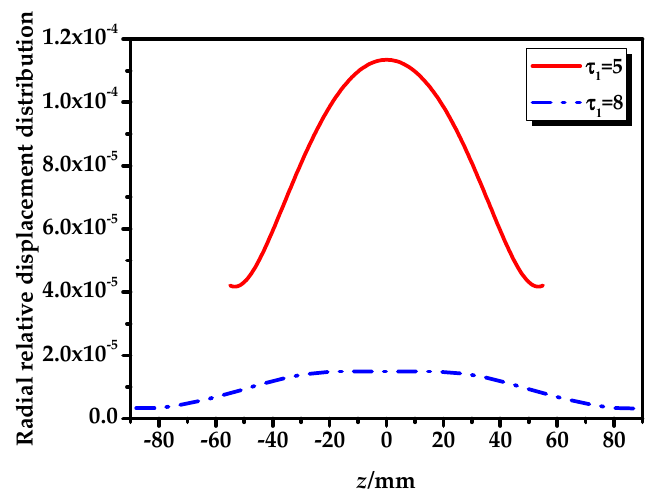
Figure 10. Radial relative displacement distributions of the No. 1 transducer with τ 1 = 5,8 at the